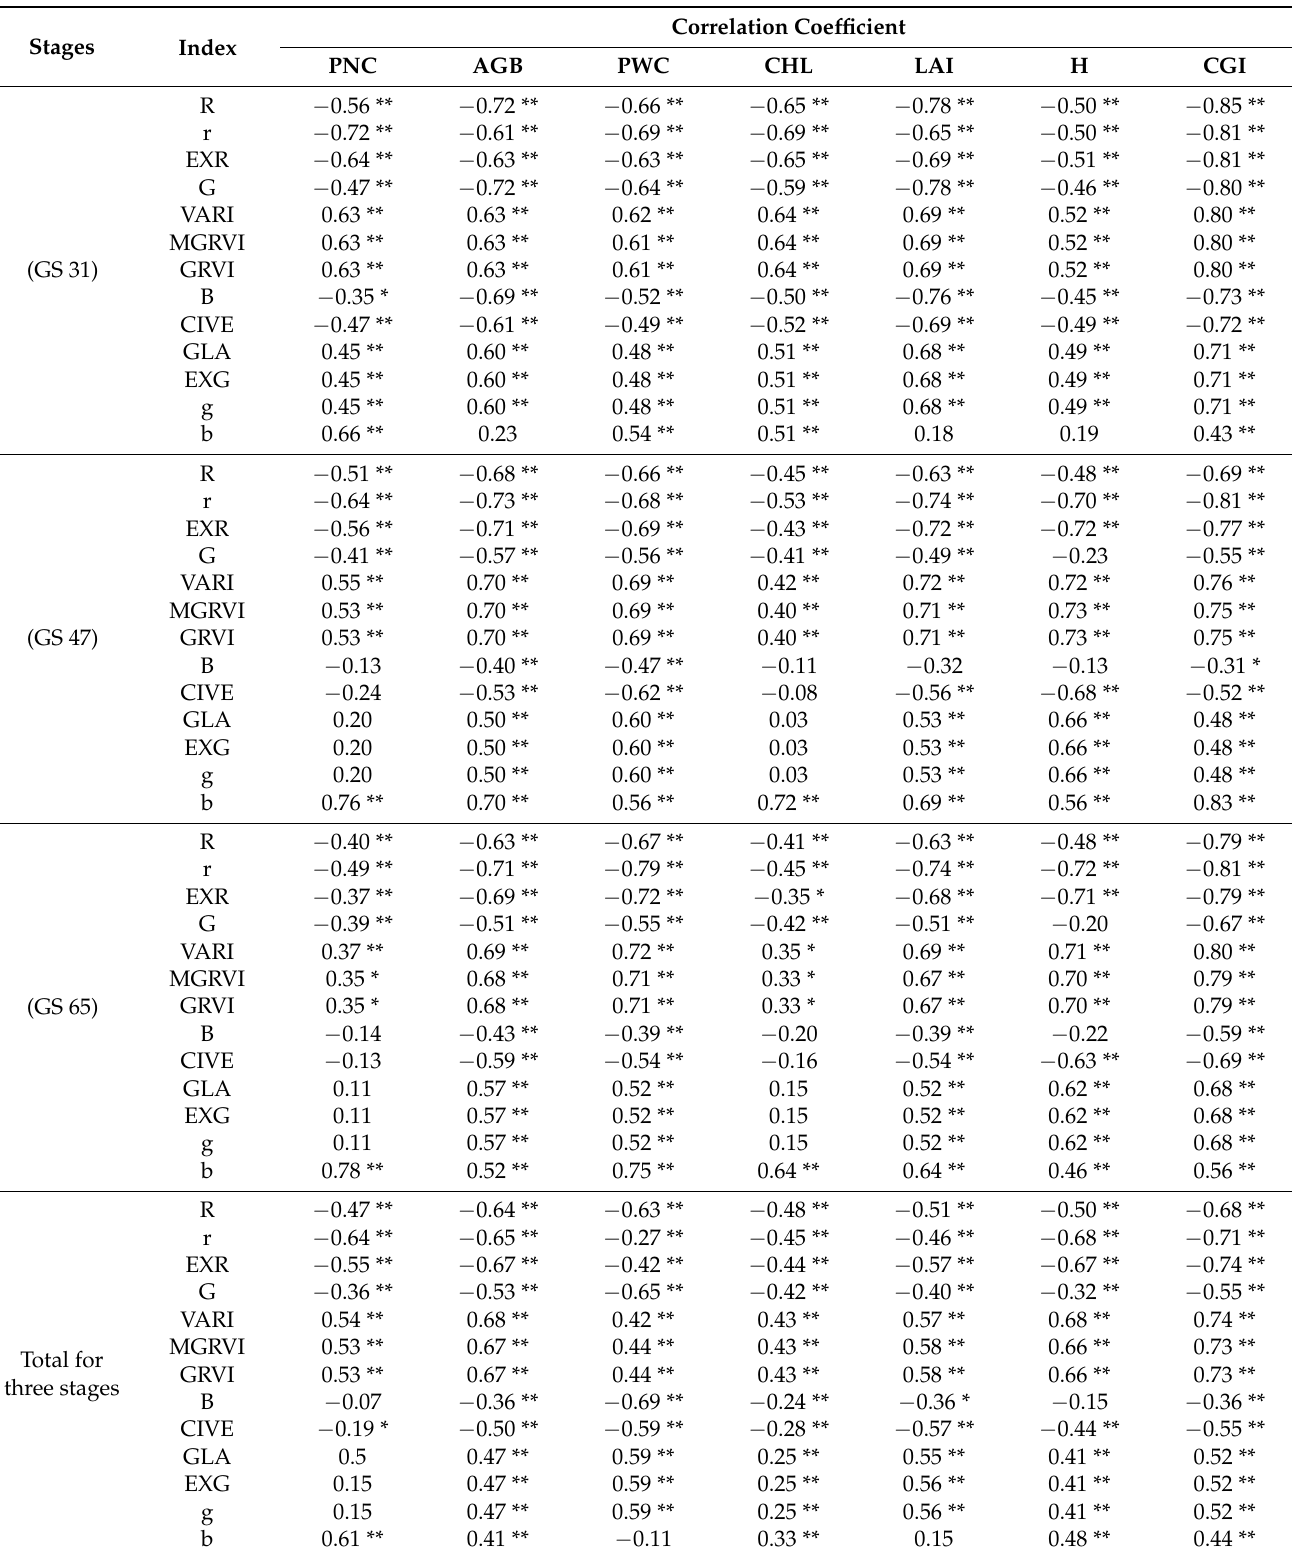
Table 2. Results of correlation analysis between RGB imagery indices and single indicator and the